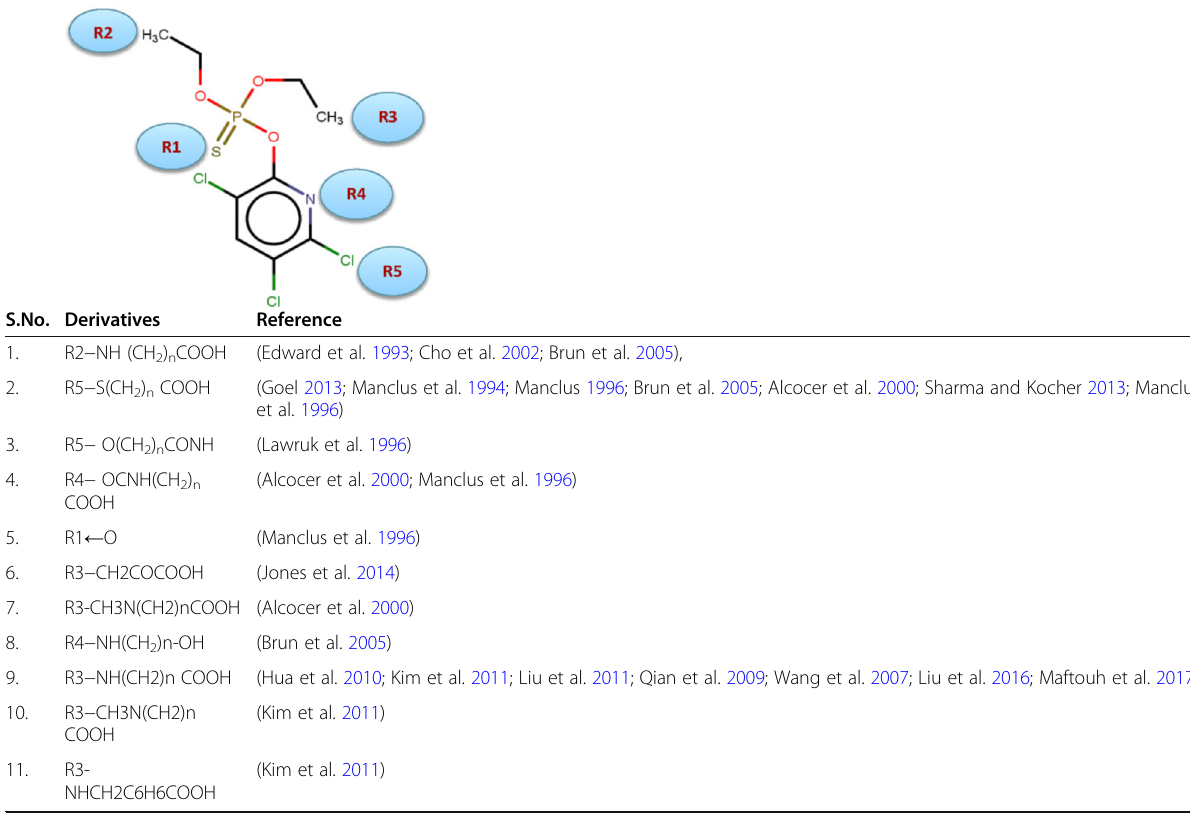
Table 1 Designed linkers to add immunogenicity to chlorpyrifos based on available literature